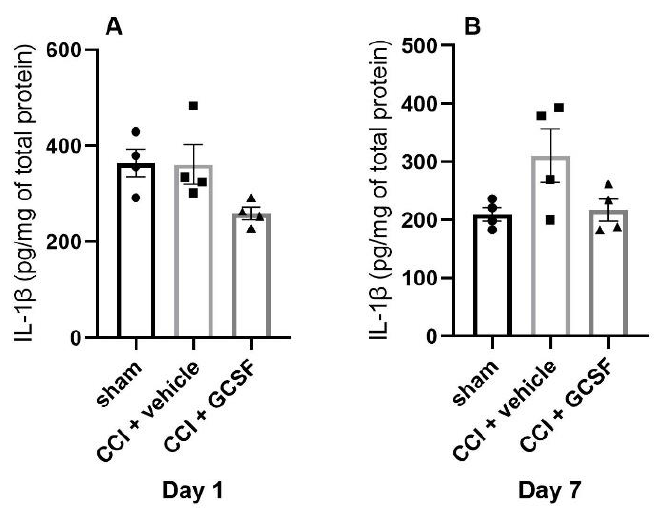
Figure 6. Pro-inflammatory cytokine IL-1β expression in the DRGs of sham-operated rats, vehicle-